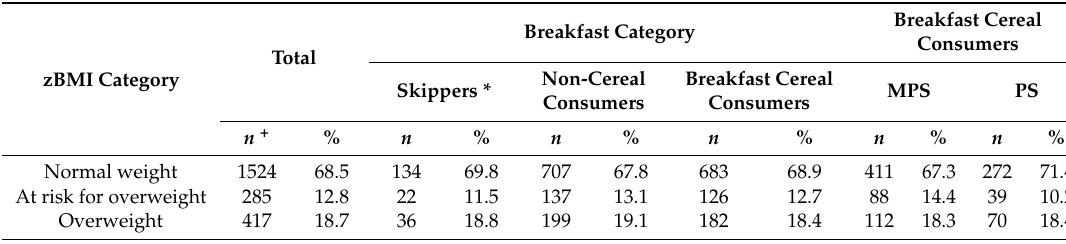
Table 5. The weighted percentage of children and adolescents, 2–18 years in each zBMI category by breakfast. Consumption and breakfast cereal type based on the 2011–2012 National Nutrition and Physical Activity Survey ( n =